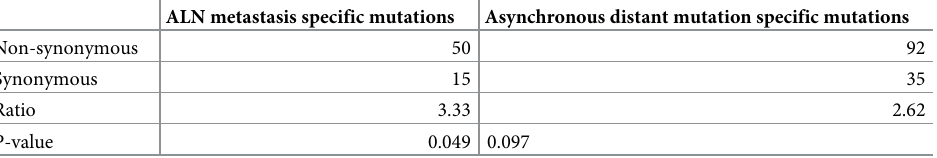
Table 3. Non-synonymous and synonymous mutations specific for mutations in ALN metastases and asynchro- nous distant metastases, respectively, collectively for the six studied patients.